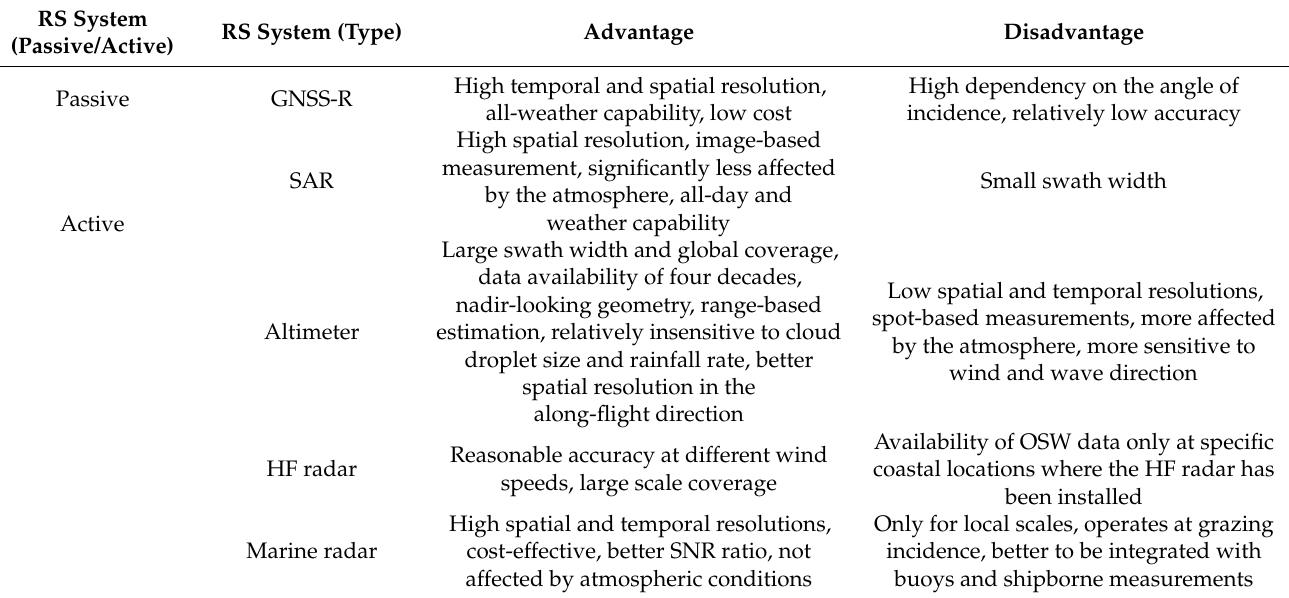
Table 3. Different RS systems for OWH estimation along with their advantages and